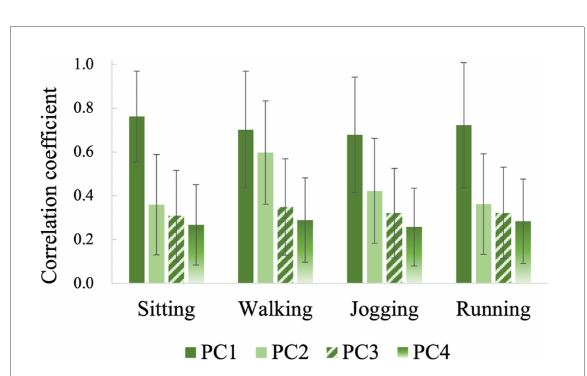
FIGURE7 The similarities between the same principal components of the samples belonging to different gestures.